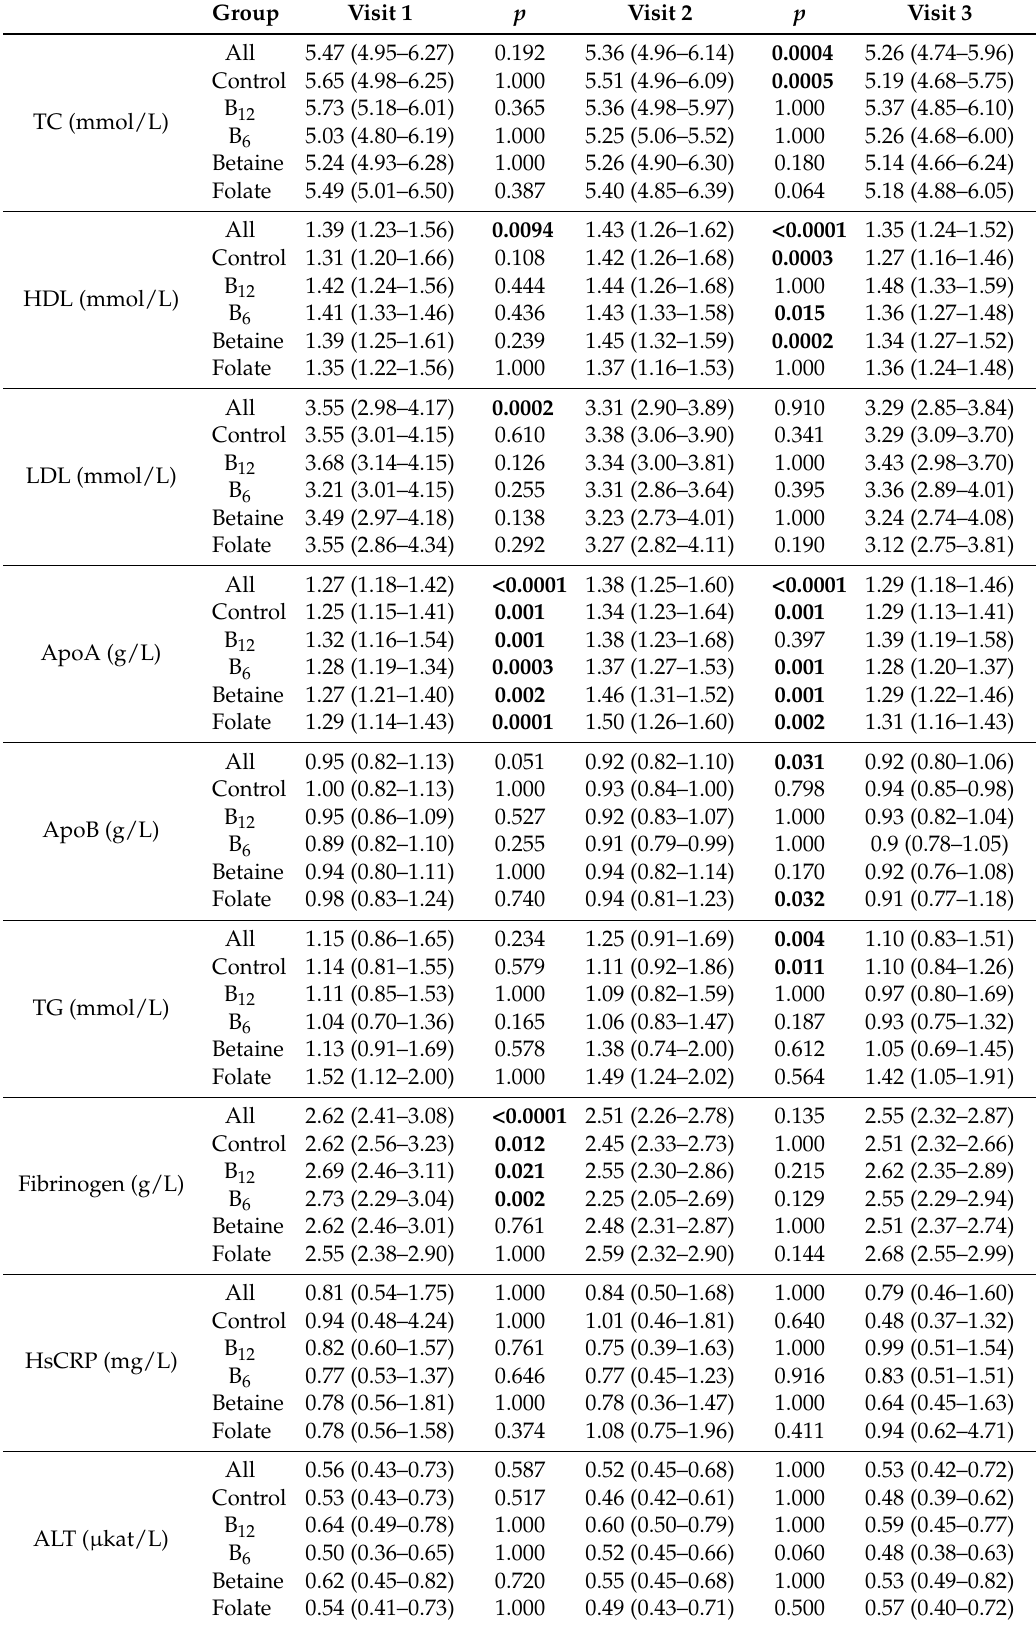
Table 5. Selected risk factors of atherosclerosis and markers of a potential toxic alcohol